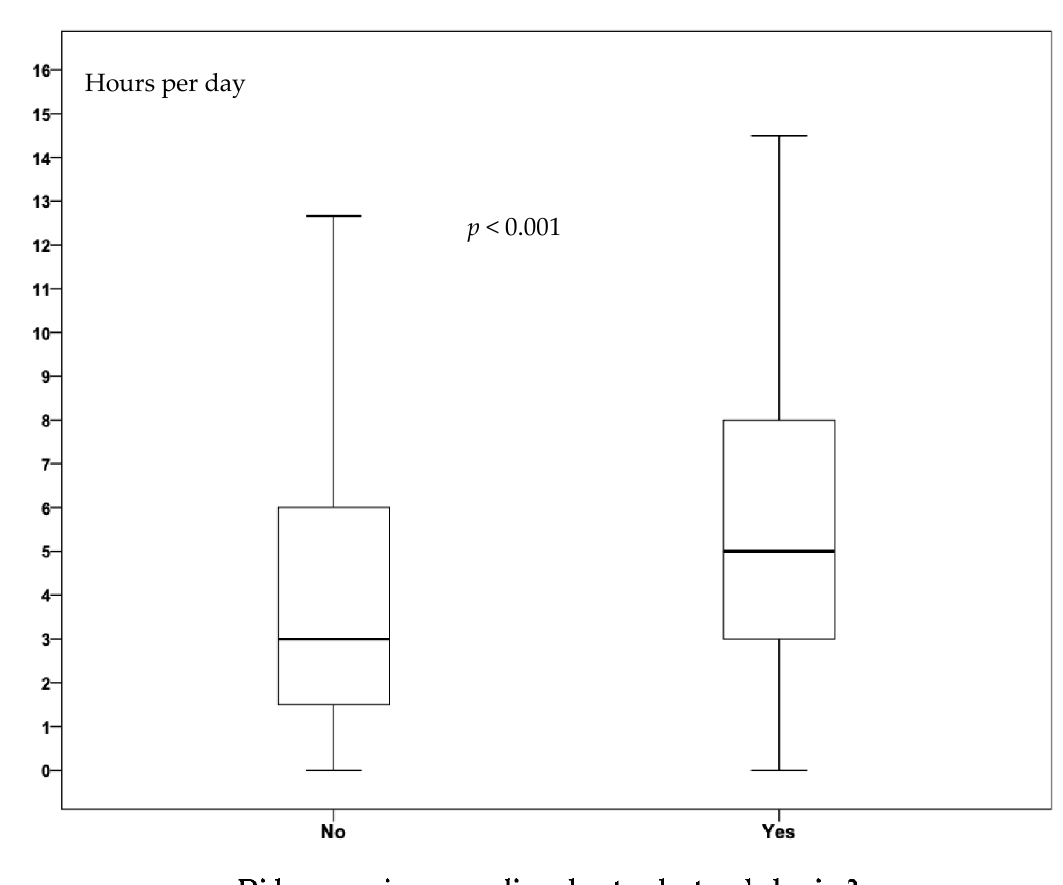
Figure 3. Median of sedentary behavior (total daily sitting time) according to counseling received from healthcare professionals by adults attending basic health units. São José dos Pinhais, Paraná, Southern Brazil, 2019 (n = 779).